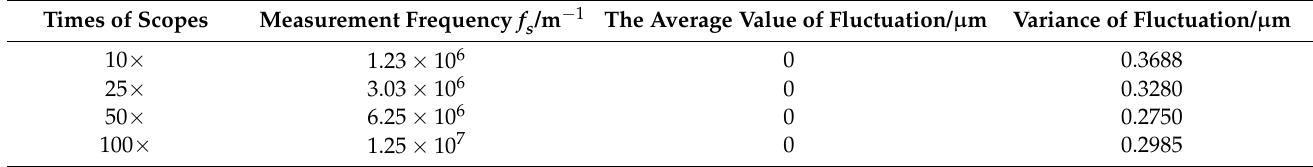
Table 8. Detailed values of fluctuation components on 9Cr18Mo surfaces.